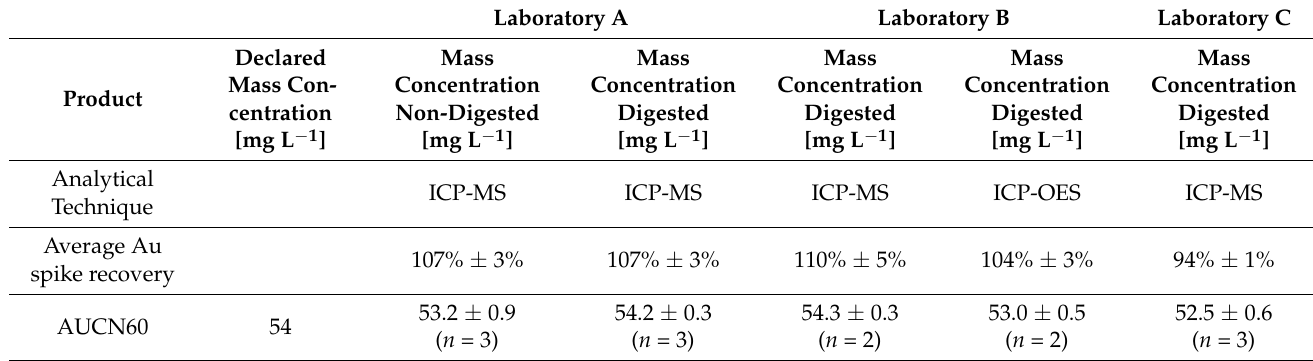
Table 6. Gold mass concentration of assessed products (declared on certificate, determined without digestion and determined following digestion). Mass concentrations were determined by three different laboratories. All uncertainties correspond to the standard